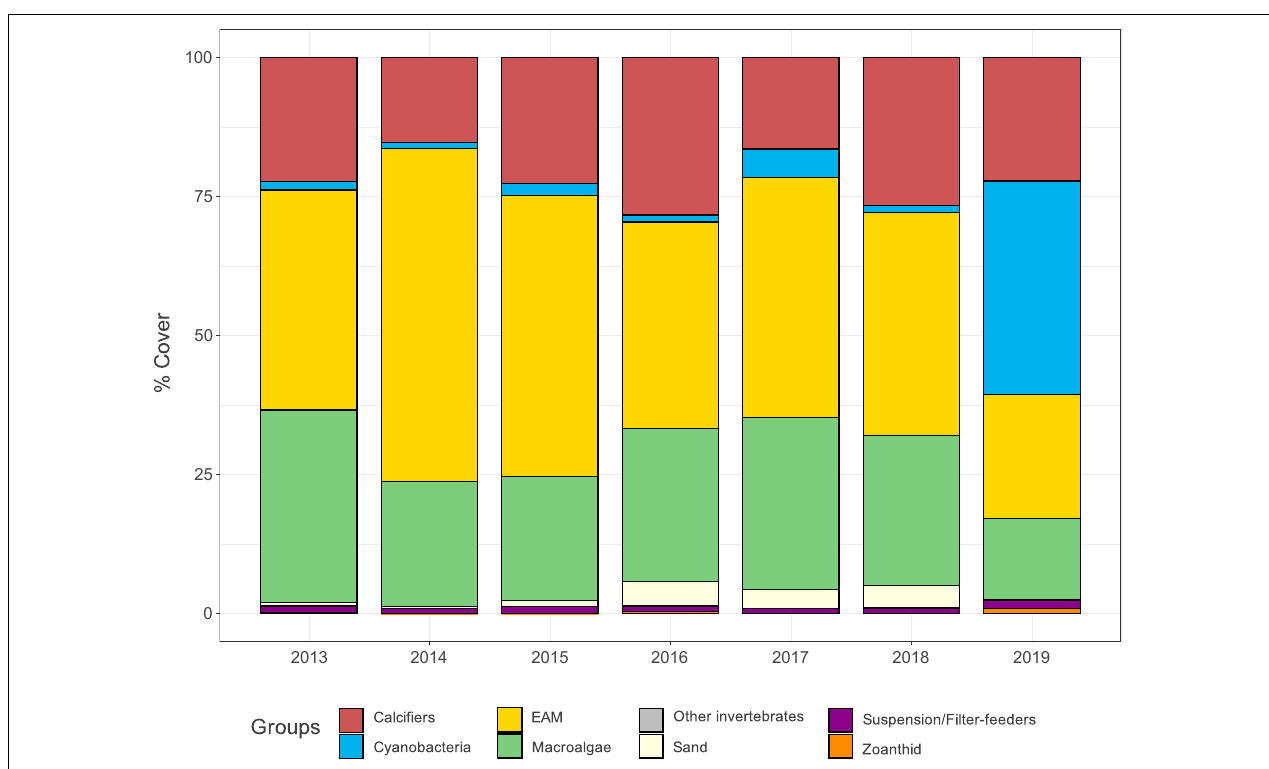
FIGURE 3 | Yearly benthic community structure. Stacked barplot illustrating the yearly substrate cover pooled during the 7-year monitoring in Fernando de Noronha Archipelago in terms of major benthic groups and sand mean percentage cover.